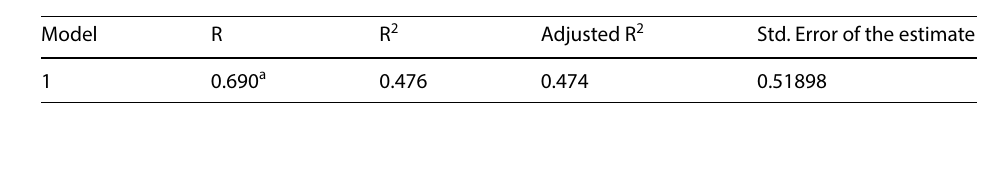
Table 4 Analysis of ANOVA results between addiction to medical websites and hypochondria